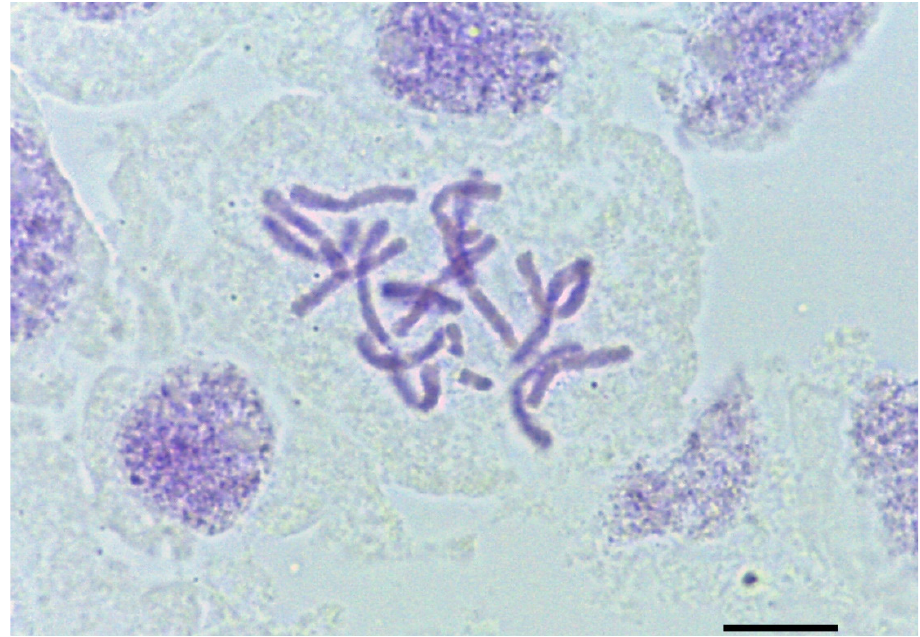
Figure 5. Mitotic metaphase plate of Allium ducissae 2n = 16 + 2B. Image obtained with a Leica DM750 light microscope (original magnification: 1000×). Scale bar: 10 μ m.